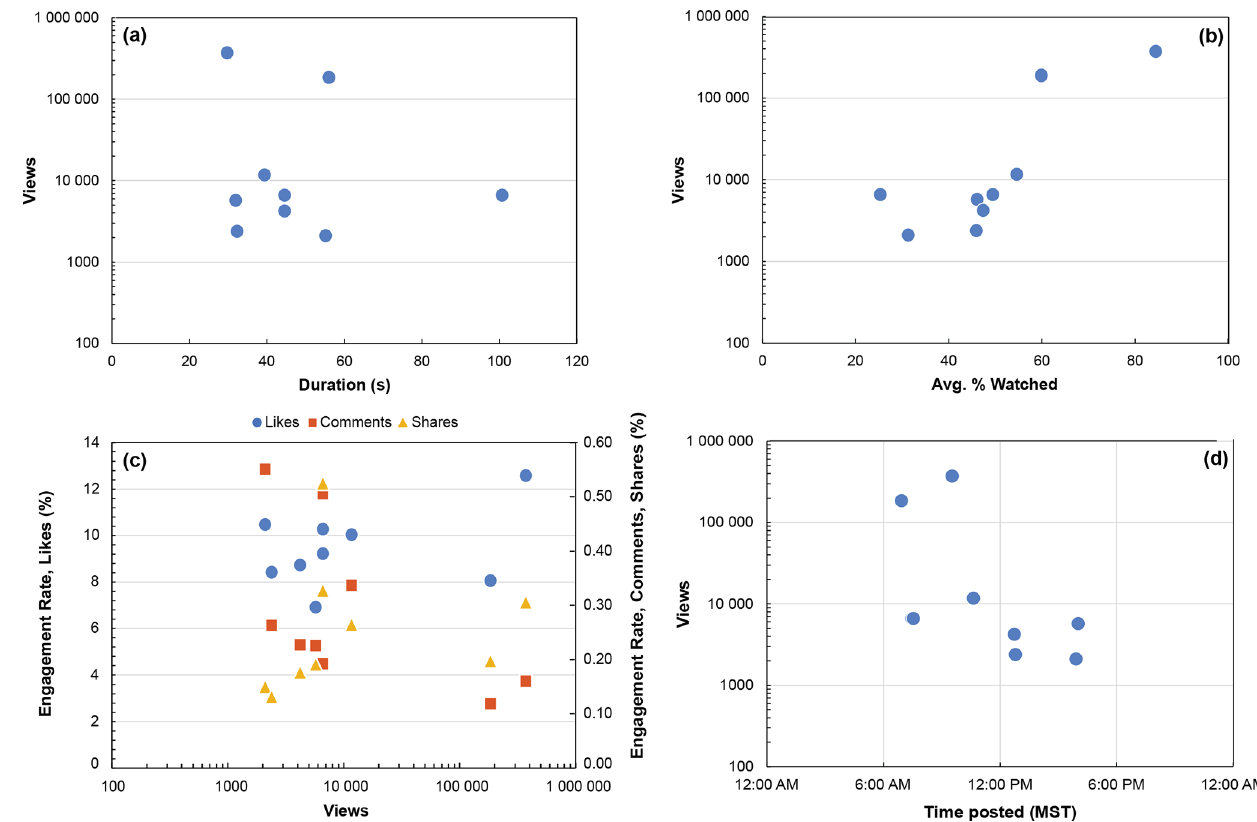
Figure 9. Video views of GMV videos on a log scale compared with (a) the duration of the video, (b) the average duration a video was watched, (c) the engagement rates of the video, and (d) the time of day the video was posted (MST, UTC − 7). There is a strong positive statistically significant correlation between the average video view duration and the number of video views ( r = 0.847, p = 0.004), but there is no statistically significant correlation ( p > 0.05) between the other parameters. See Supplement for full correlation